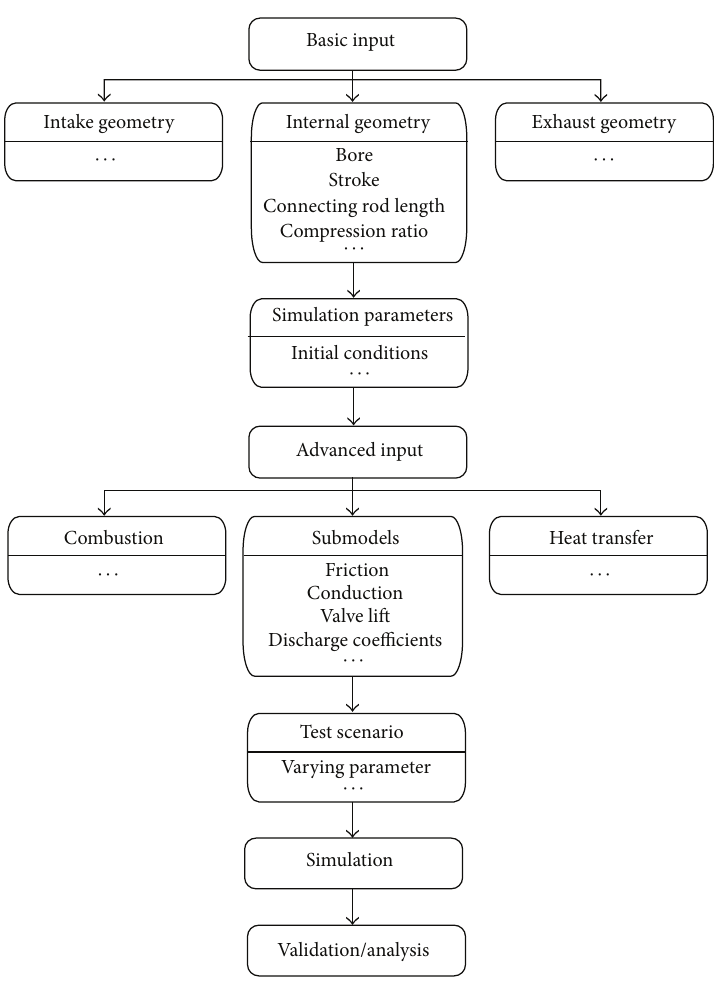
Figure 5: Development of engine